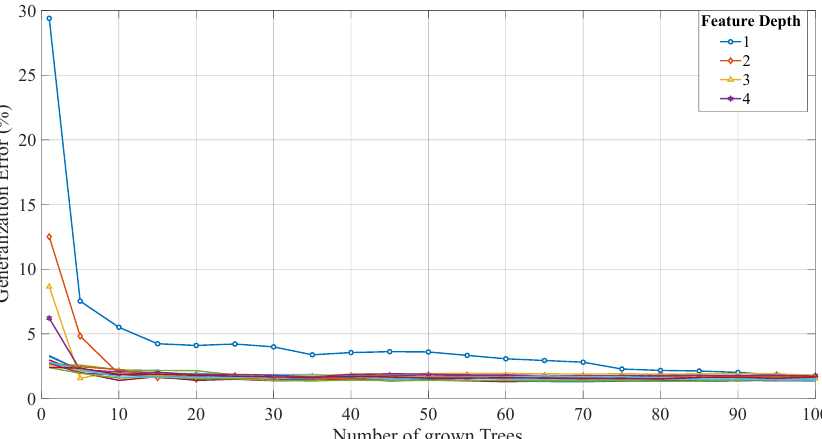
Figure 11. The generalization error results for the AdaBoostM2 ensemble method with a minimum leaf size of 3 and a learning rate of 0.61992, for a range of decision tree learners and feature depths. The error stabilizes between 1.2 and 1.9% and the unique feature depth trends are